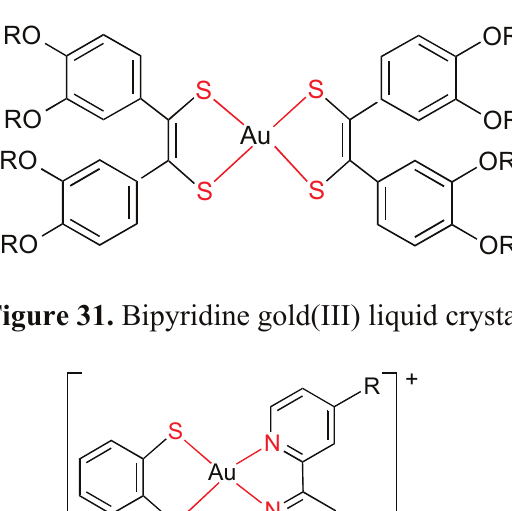
Figure 30. Gold(III) mesogen containing dithiolene ligands. R = C